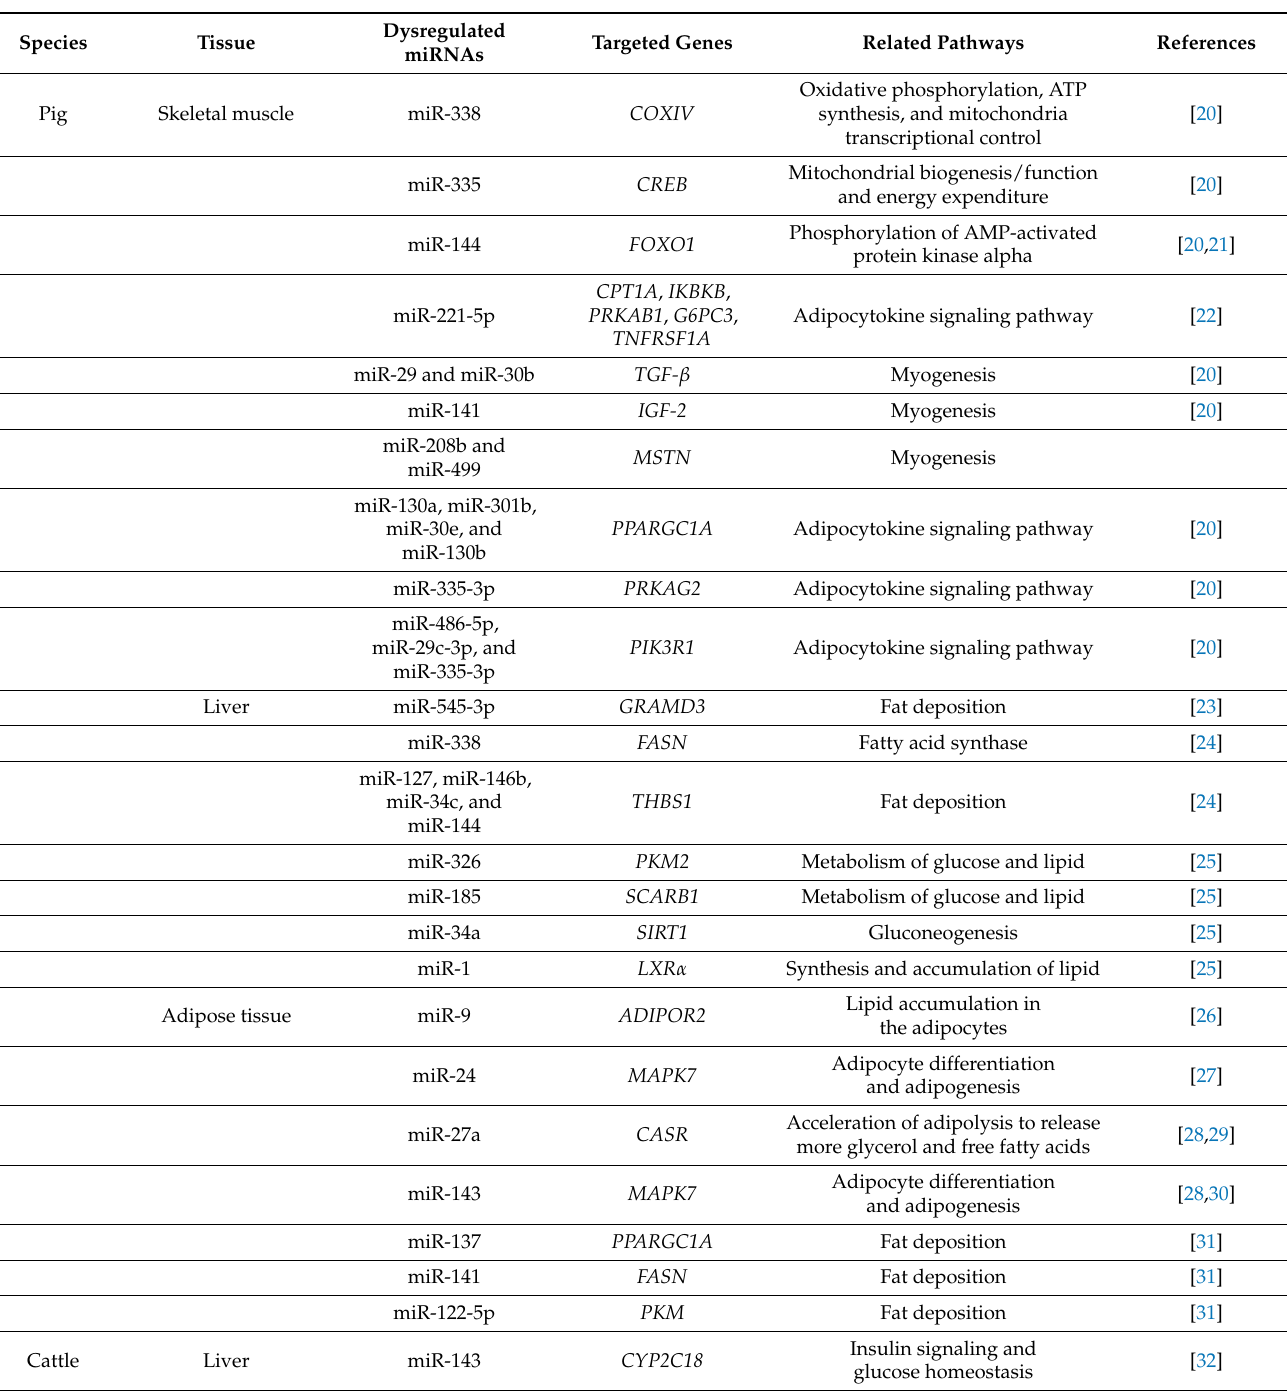
Table 2. The miRNAs involved in the feed efficiency of different livestock